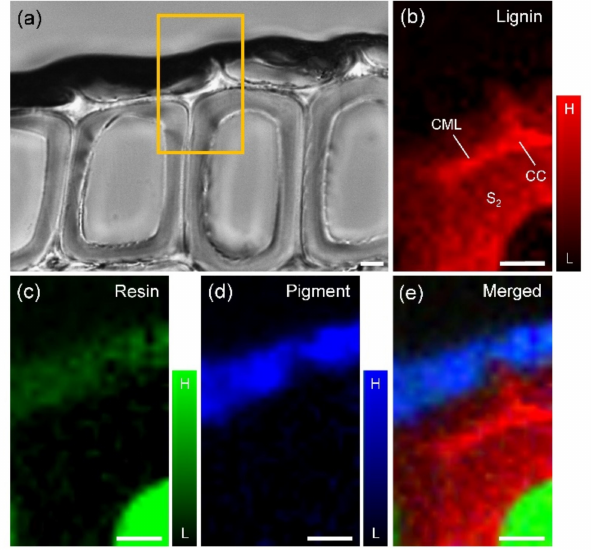
Figure 2. Raman mapping on the cross-section of coated wood surface. Bright-field image shows the area selected for mapping (orange rectangle) ( a ). Raman images were calculated by integrating the Raman bands from 1132 to 1139 cm − 1 ( b , lignin), from 1721 to 1734 cm − 1 ( c , alkyd resin), and from 281 to 309 cm − 1 ( d , pigment). Merged image is an overlay of the distribution of lignin, alkyd resin, and pigment ( e ). S 2 : middle layer of secondary cell wall, CML: compound middle lamella, CC: cell corner. Scale bars: 5 µ m.